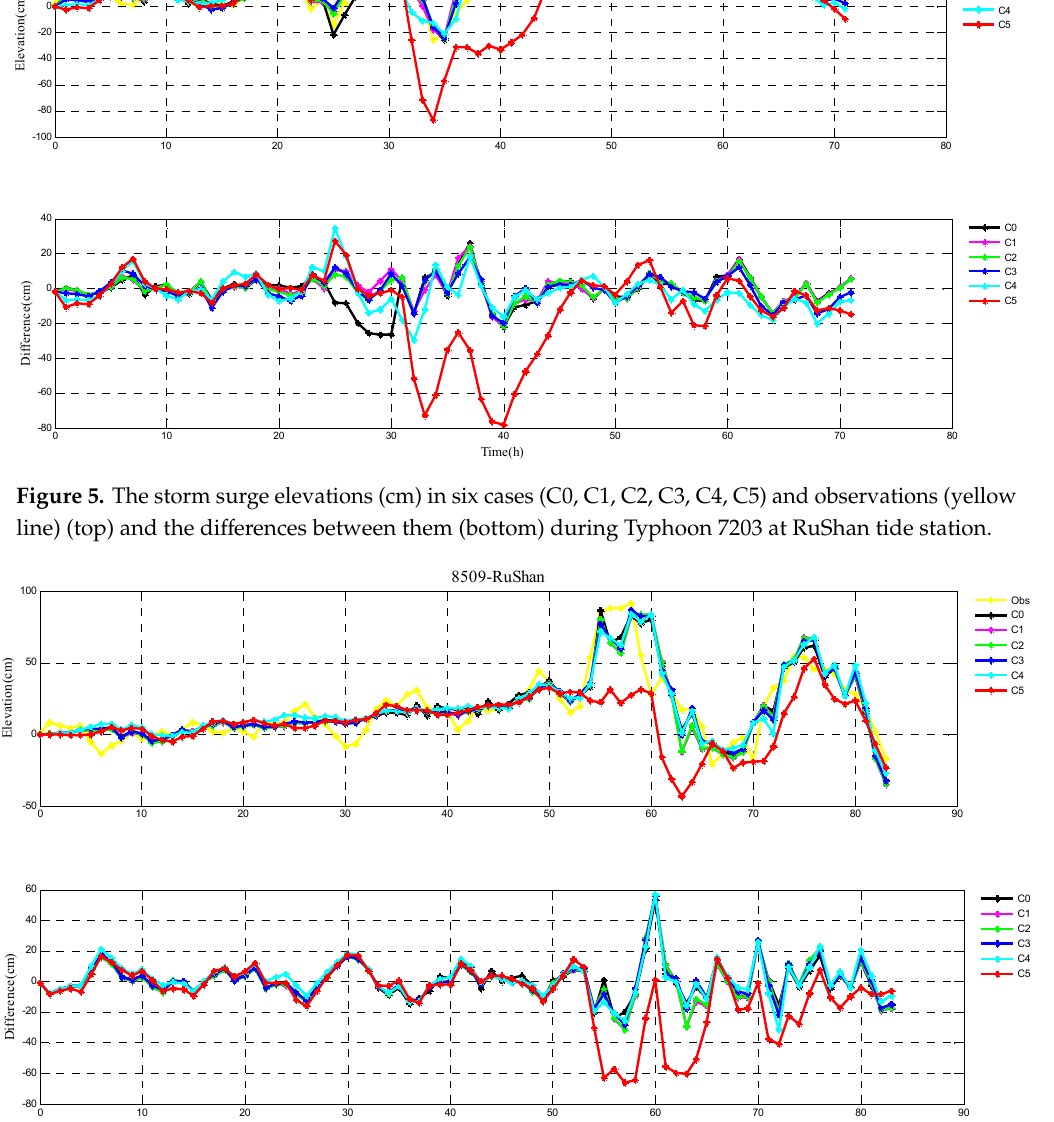
Figure 6. The storm surge elevations (cm) in six cases (C0, C1, C2, C3, C4, C5) and observations (yellow line) (top) and the differences between them (bottom) during Typhoon 8509 at RuShan tide station.